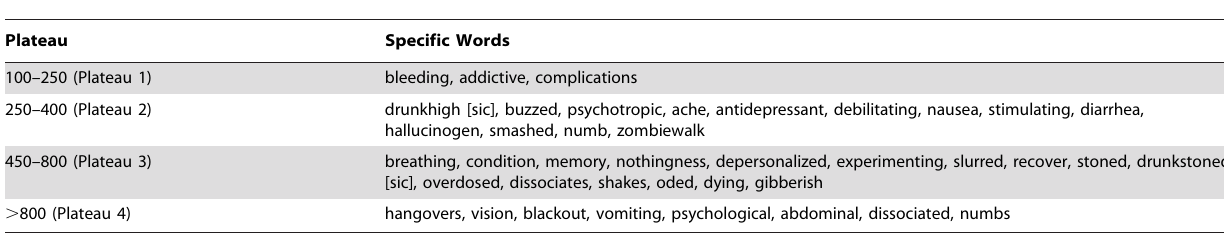
Table 2. Words specific to each plateau.